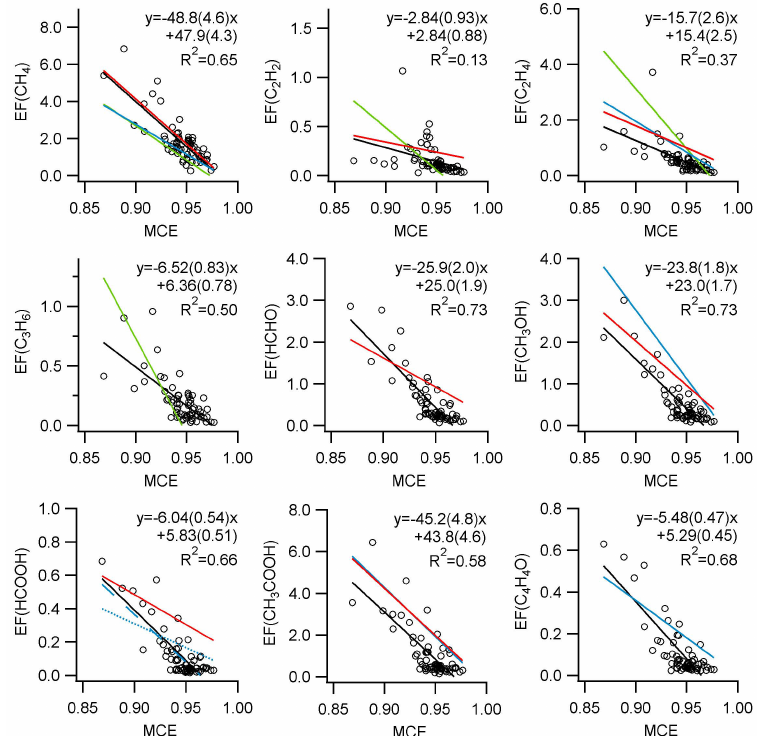
Fig. 3. Emission factors (g kg − 1 ) plotted as a function of modified combustion efficiency (MCE) for carbon-containing gas-phase species measured by OP-FTIR for the southeastern and southwestern fuels. The quantities in brackets represent the 1 σ standard error of the slope and y-intercept. Also shown here are the lines of best fit from several studies (black line – this study; red line – Yokelson et al. (2003); green line – McMeeking et al. (2009); blue line – Christian et al. (2003). The blue lines for HCOOH in the lower left plot are unpublished results from the data of Christian et al. (2003) for African fuels (dotted line) and Indonesian fuels (dashed